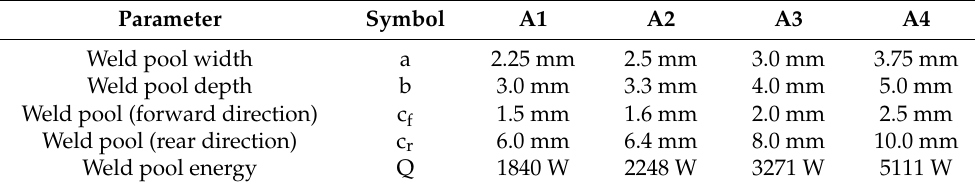
Table 1. Goldak’s ellipsoidal heat source parameters for different dimension beads.